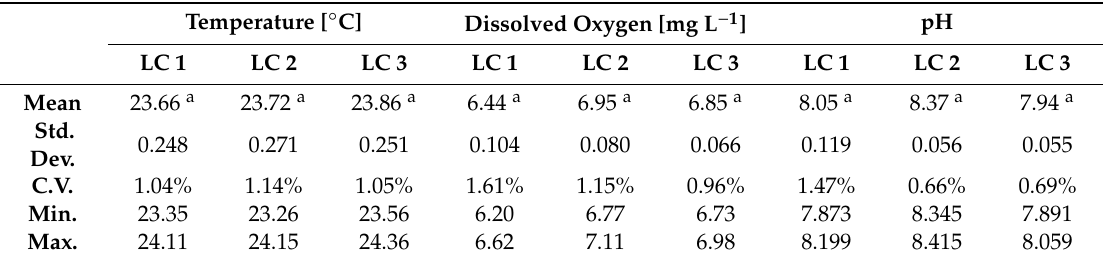
Table 2. Comparison of temperature, dissolved oxygen, and pH in three repetitions. a : statistically